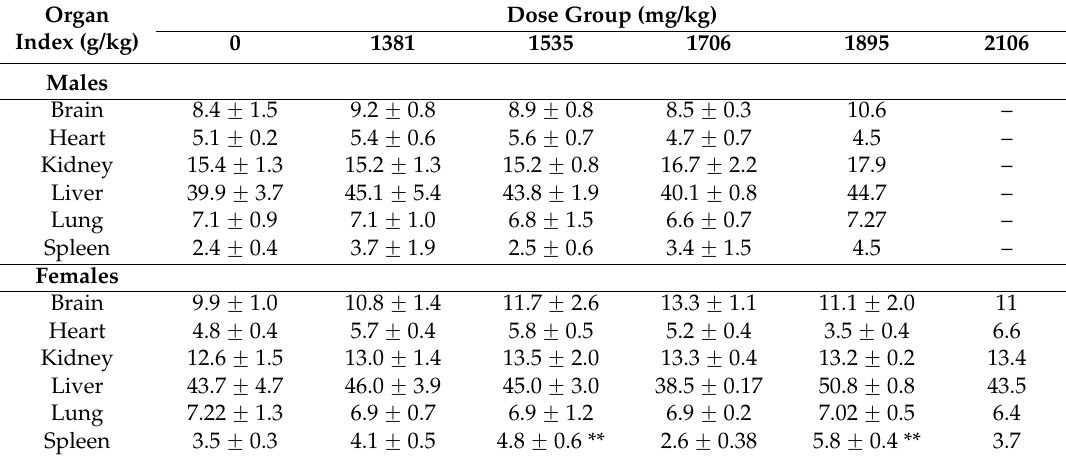
Table 2. Effects of SalB-Rg1 with a single dose on the organ index in acute toxicity.